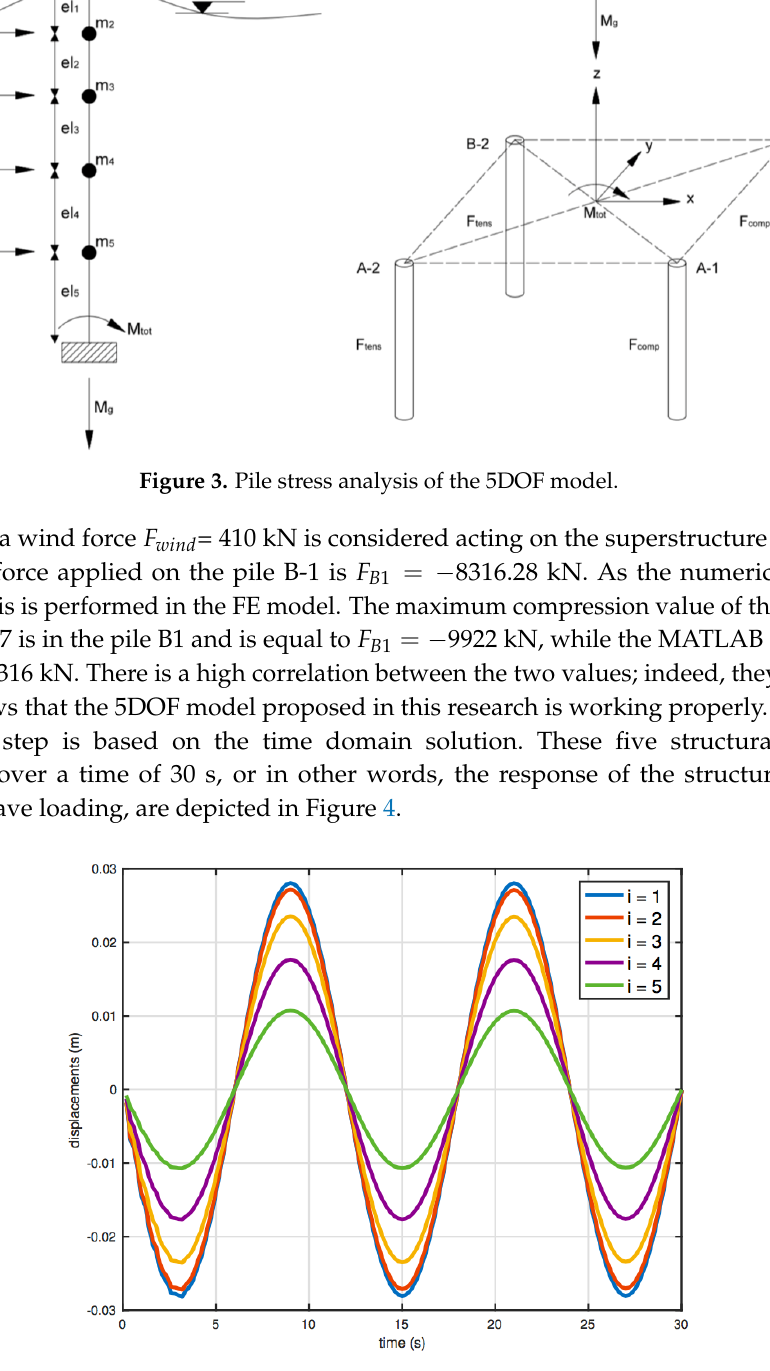
Figure 4. Time domain plot of the 5DOF